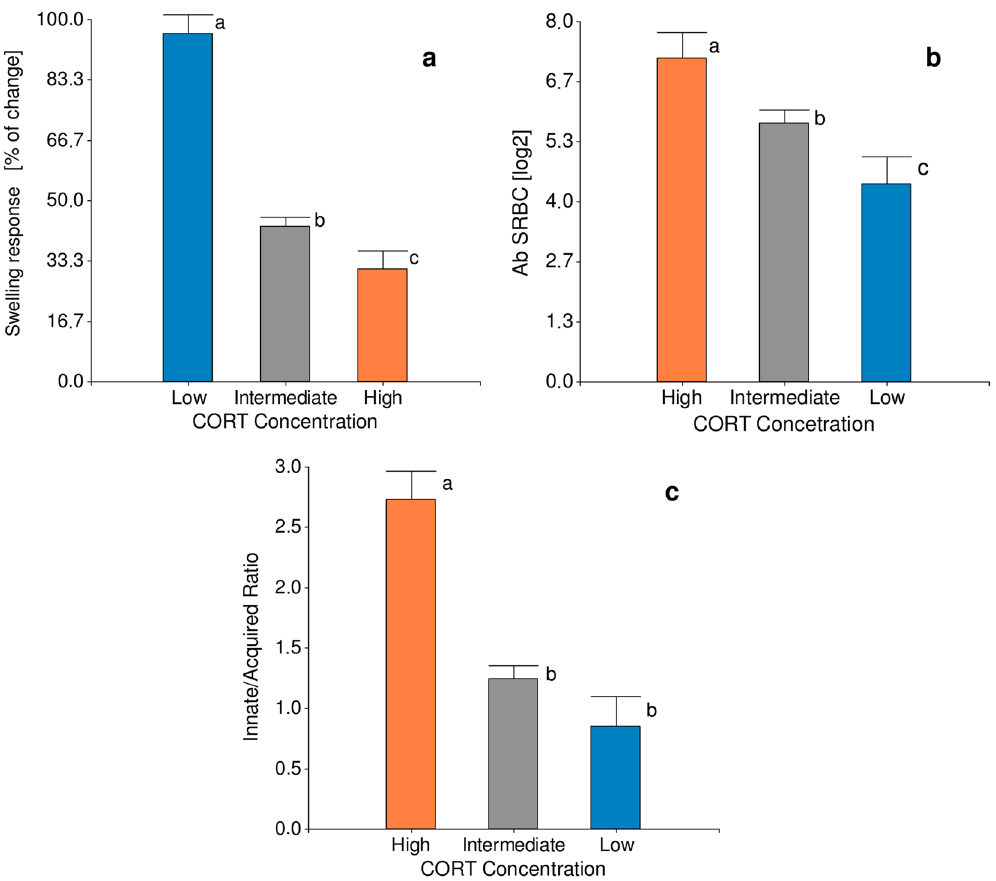
Figure 3. Immune effector analysis in divergent Low and High CORT groups. Effect of clustering on immune effectors is shown in ( a ) skin-swelling response to PHA-P, ( b ) antibody response against SRBC and ( c ) INN/ ACQ. Data are means ± SE. Different letters indicate significant ( p < 0.05) differences between groups. Number of birds per group Low = 10, High = 11, Intermediate = 46. INN/ACQ number was calculated using the following formula: INN/ACQ = (number of basophils + number of heterophils + number of monocytes)/ (number of eosinophils + number of